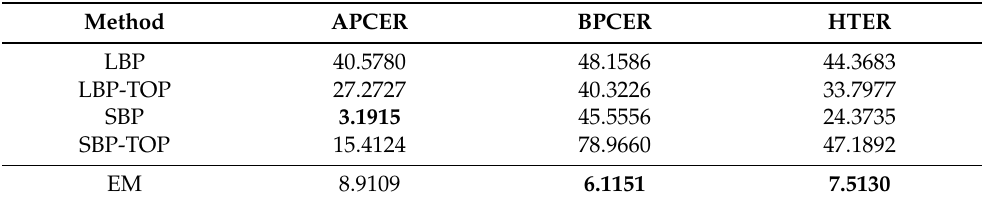
Table 3. Results of existing baseline spoofing detection methods (%) on our testing database after training using our training database.